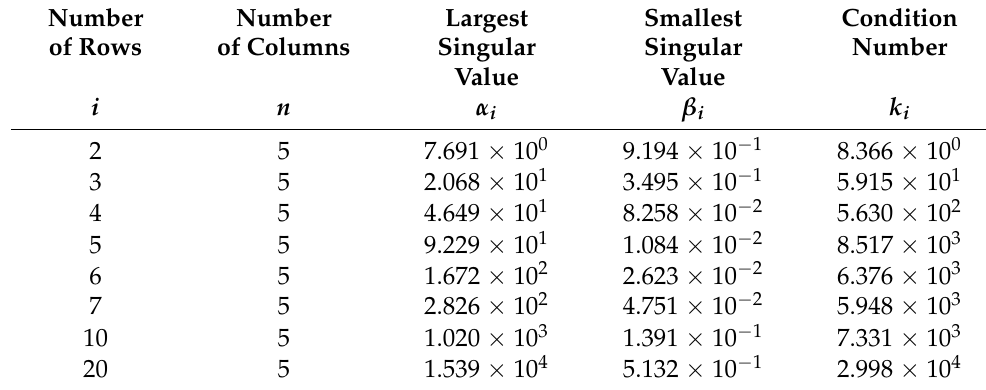
Table 3. Failure of the anomaly in small Pascal matrix.